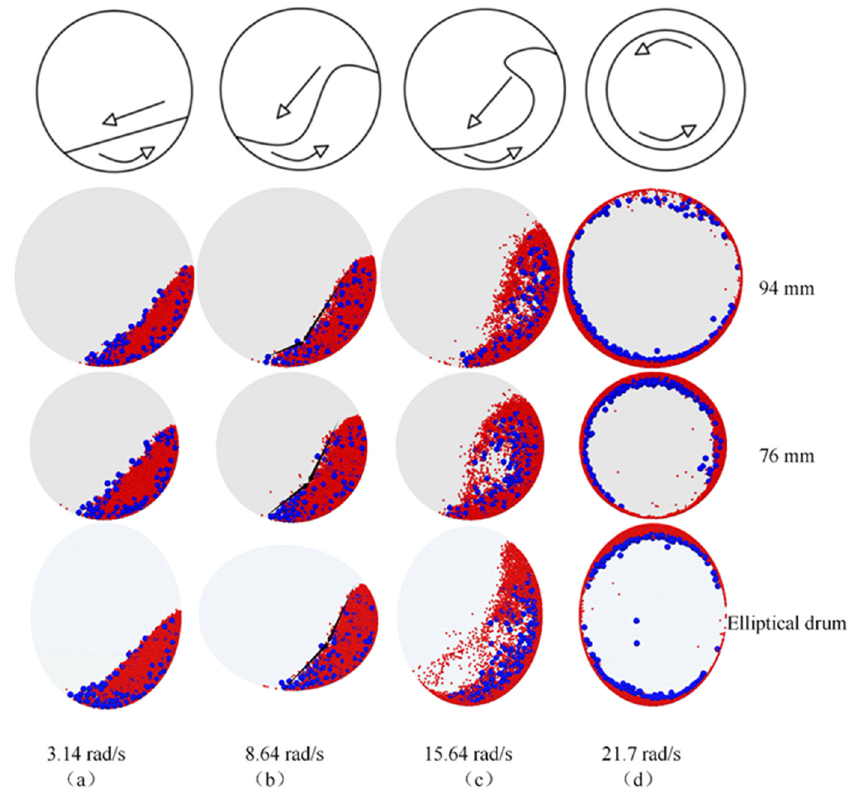
Figure 3. Different flow regimes of the binary particle system in rotating drums. ( a ) Rolling; ( b ) cascading; ( c ) cataracting; ( d ) centrifuging.